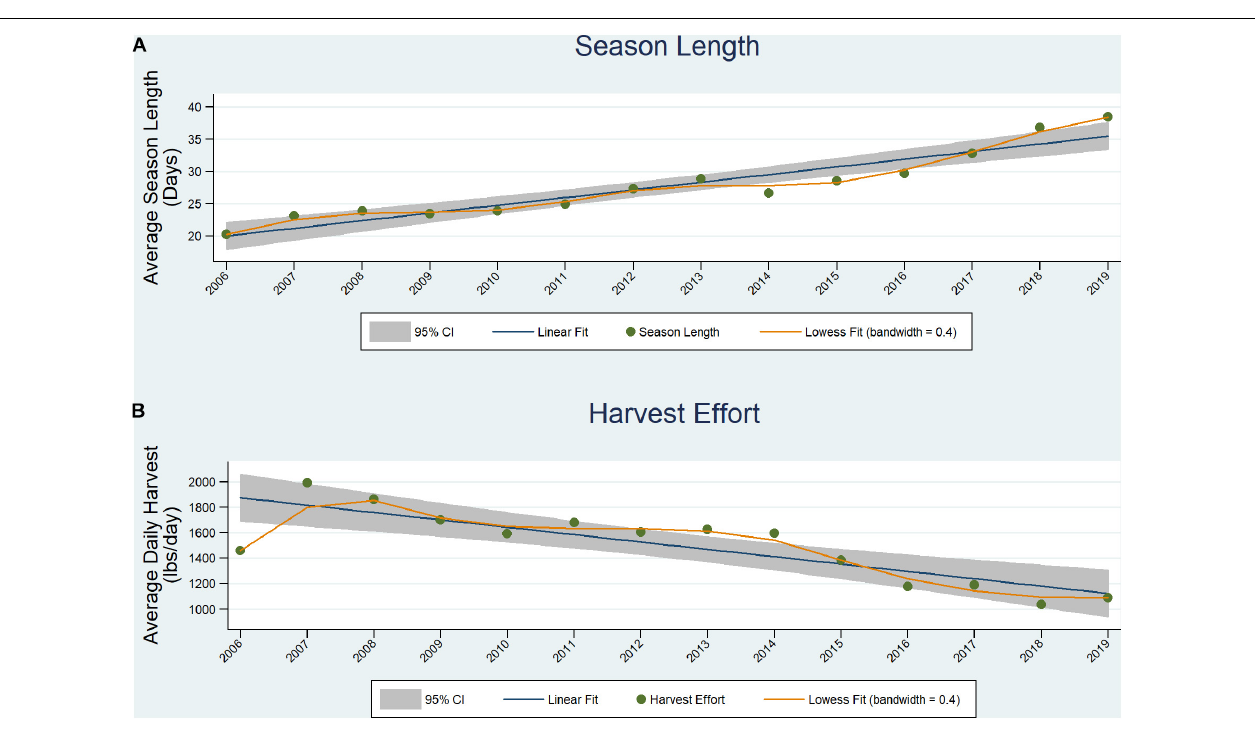
FIGURE 6 | Average season length in days (A) and average catch per day in pounds (B) for sablefish IFQ vessels. Figure includes the linear fit line and the 95% confidence interval around that line and the LOWESS fit curve calculated using a 0.4